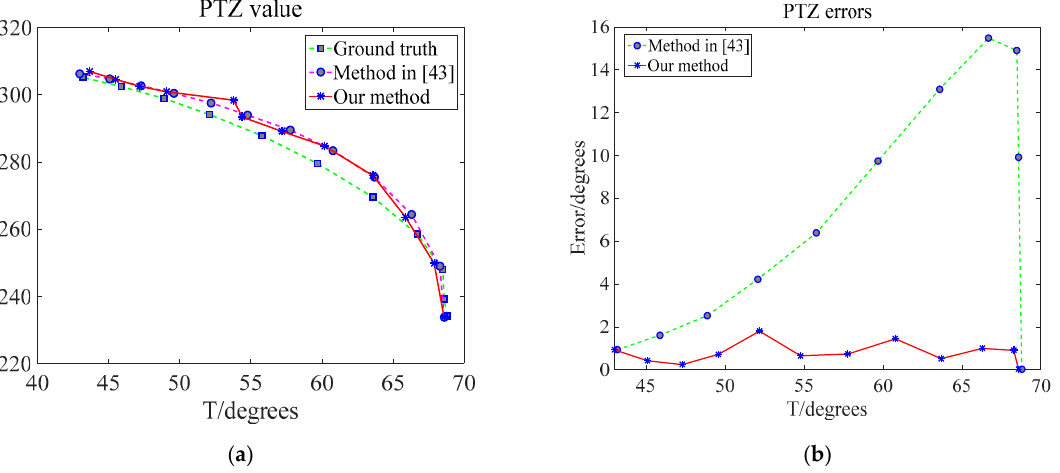
Figure 16. Observation angle and angle errors of the PTZ camera in the vertical channel. ( a ) PTZ value. ( b ) PTZ errors. value. ( b ) PTZ errors